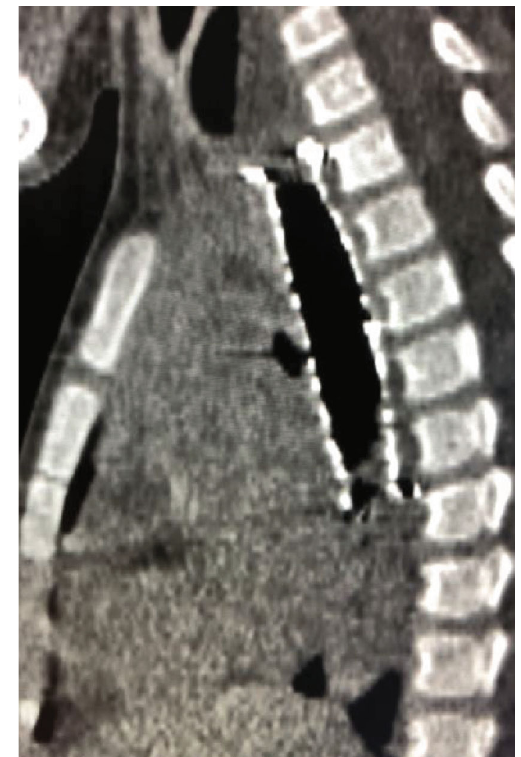
Figure 3: A SEMS under the esophageal stricture